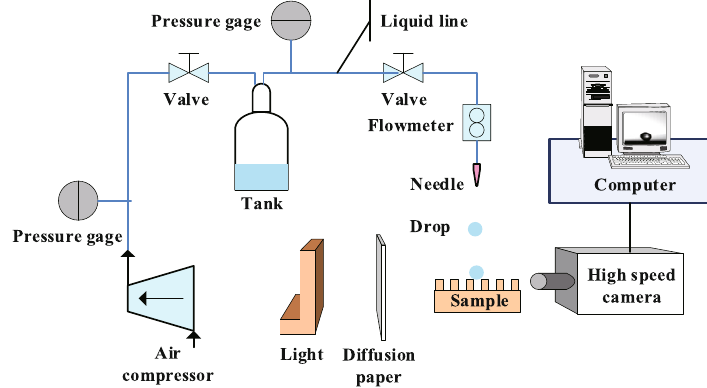
Fig. 2 Schematic illustration of water drop-impacting experimental